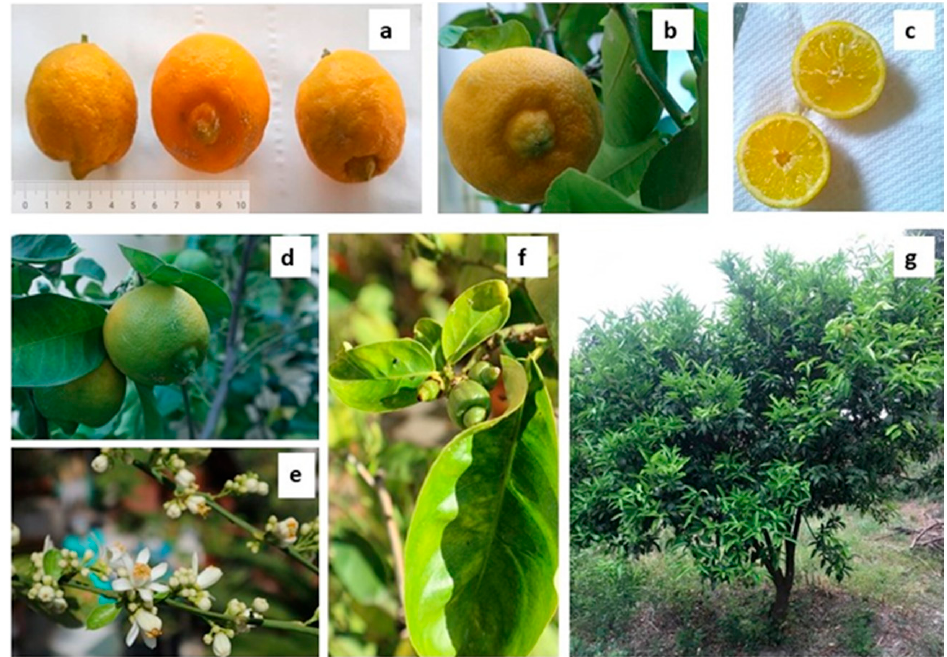
Figure 1. Neapolitan limmo or lemoncetta Locrese. ( a,b ) Ripe fruits are sulfur-yellow in color and have a diameter of 4–5 cm. ( c ) Fruit section with 8–10 loggias. ( d ) Ripe fruits with greenish color. ( e ) Young leaves and flowers. ( f ) Leaves and small fruits. ( g ) Neapolitan limmo tree.